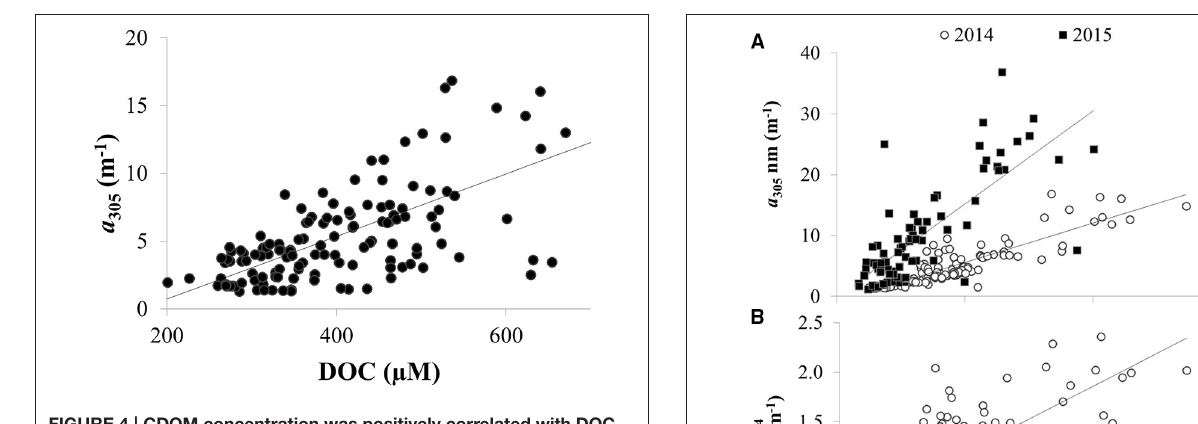
FIGURE 4 | CDOM concentration was positively correlated with DOC concentrations in Lake Erie in 2014 as shown for CDOM absorption coefficient at 305nm ( a 305 ) ( R 2 = 0.4 ; p < 0.01 ). Similar results were obtained using CDOM absorption coefficients at other wavelengths (not shown).